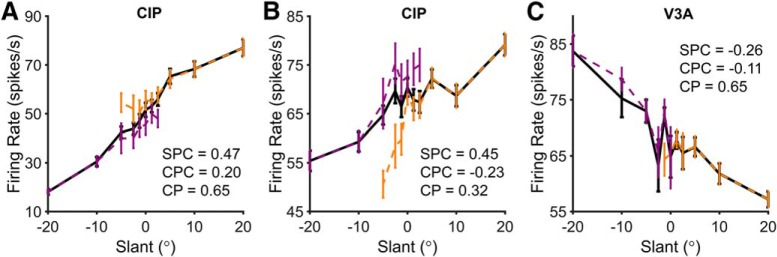
Example CIP and V3A neurons illustrating the effect of choice on slant tuning. For each neuron, the black curve shows the slant tuning curve created by averaging responses regardless of choice. Orange and purple curves show choice-conditioned slant tuning curves created by separating responses into top-far vs top-near choices, respectively. The SPC, CPC, and CP are listed for each neuron. A, CIP neuron with a positive SPC, a positive CPC, and a CP > 0.50 (p = 0.001). B, CIP neuron with a positive SPC, a negative CPC, and a CP < 0.50 (p = 0.001). C, V3A neuron with a negative SPC, a negative CPC, and a CP > 0.50 (p = 0.29).